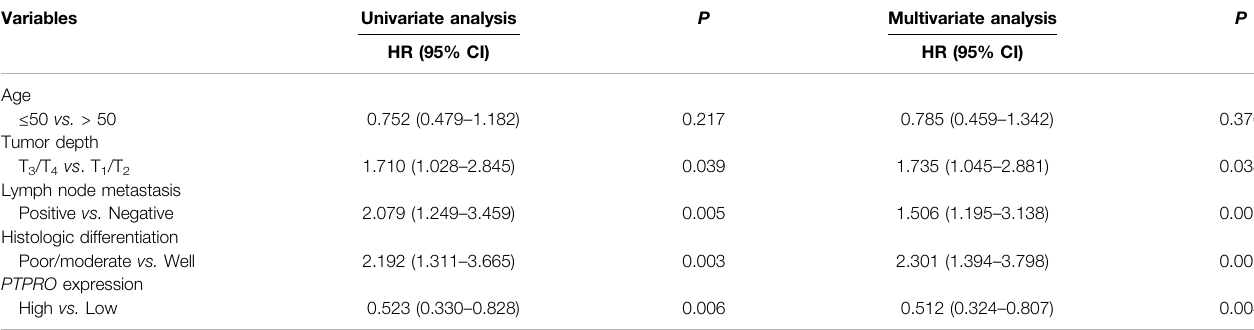
TABLE 2 | Univariate and multivariate Cox proportional hazards model predicting survival in ERBB2-positive breast cancer patients. Variables Univariate analysis P Multivariate analysis P HR (95% CI) HR (95% CI) Age ≤ 50 vs. > 50 0.752 (0.479 – 1.182) 0.217 0.785 (0.459 – 1.342) 0.376 Tumor depth T 3 /T 4 vs . T 1 /T 2 1.710 (1.028 – 2.845) 1.735 (1.045 – 2.881) 0.033 Lymph node metastasis Positive vs. Negative 2.079 (1.249 – 3.459) 1.506 (1.195 – 3.138) 0.007 Histologic differentiation Poor/moderate vs. Well 0.001 PTPRO expression High vs.